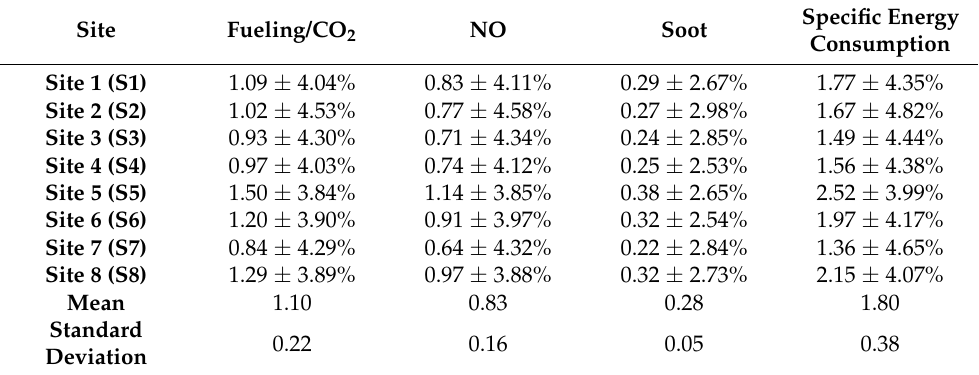
Table 6. Monte Carlo simulation method results (mean values and standard deviations are %; all other values correspond to rise % over the reference